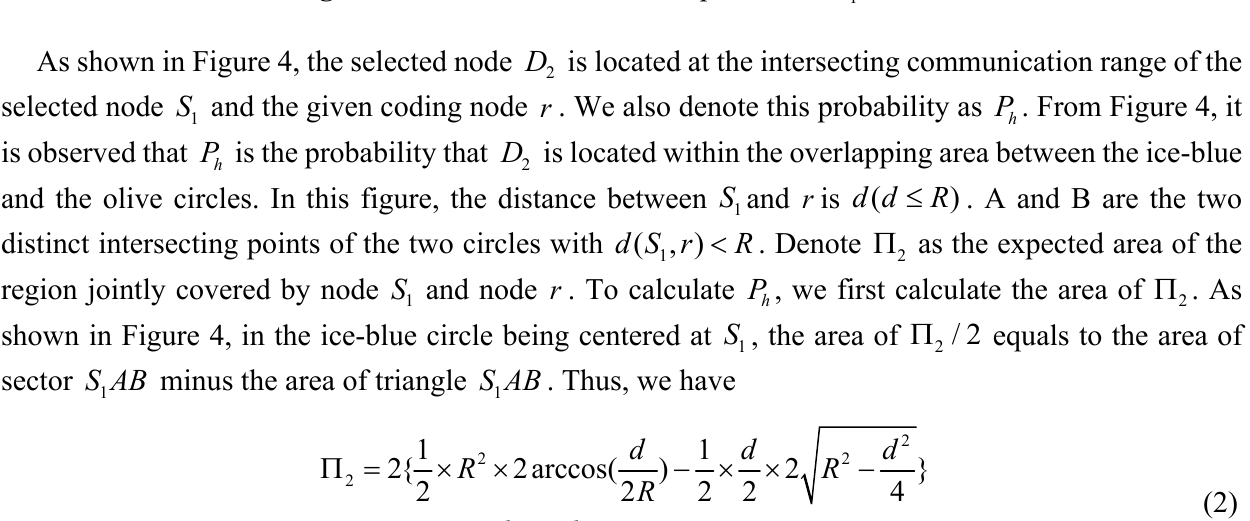
Figure 4. The location relationship between